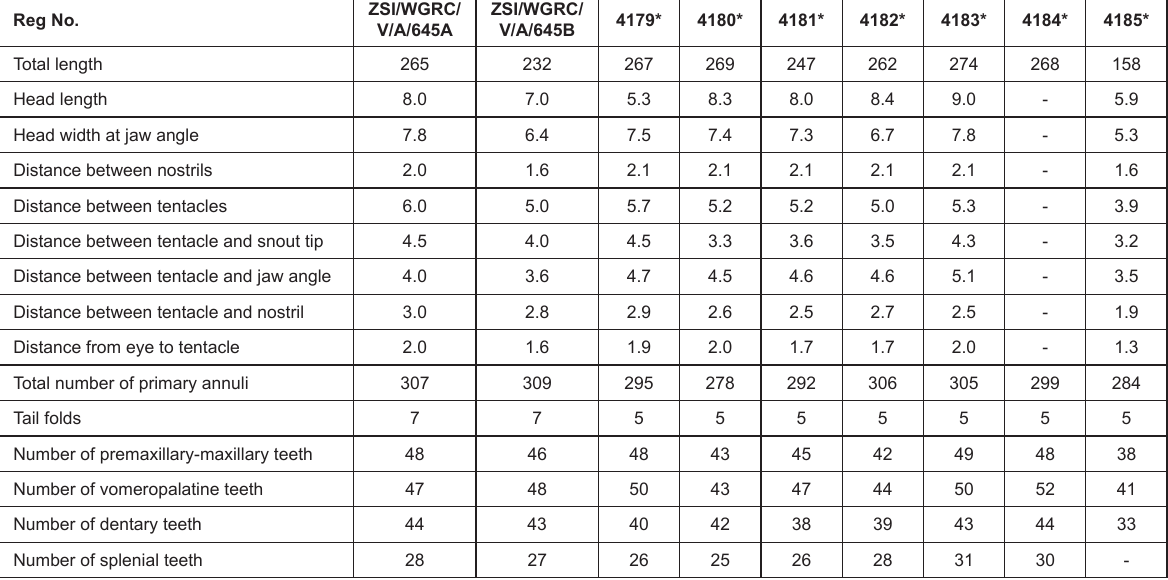
* data from Wilkinson et al.